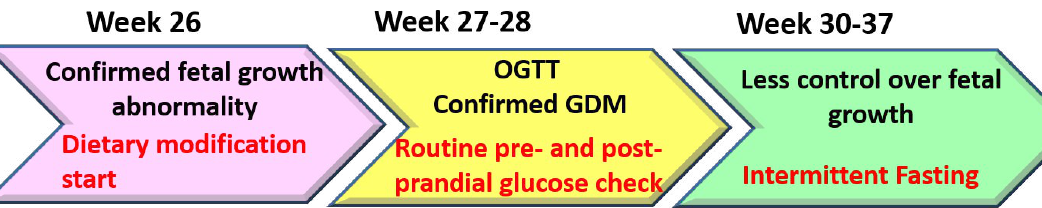
Figure 4. A time-sequence illustration of gestational diabetes mellitus (GDM) diagnosis, change in fetal growth, and the use of dietary modifications / intermittent fasting interventions. During the 26th gestational week, exaggerated fetal growth suggested GDM occurrence. The patient immediately refrained from the intake of refined carbohydrates. An oral glucose tolerance test (OGTT) was performed during the 27th week. The patient practiced light exercise in addition to low carbohydrate consumption. At the end of the 28th week the patient started recording her blood glucose level on a daily basis directly before each meal and 2 h after dining. Fluctuations in the 2 h post-prandial glucose level, in addition to the persistence of abnormal fetal growth, forced the patient to medicate her GDM through intermittent fasting starting from the 30th gestational week. During the fasting course, the patient retained exercise and the previous modification in diet